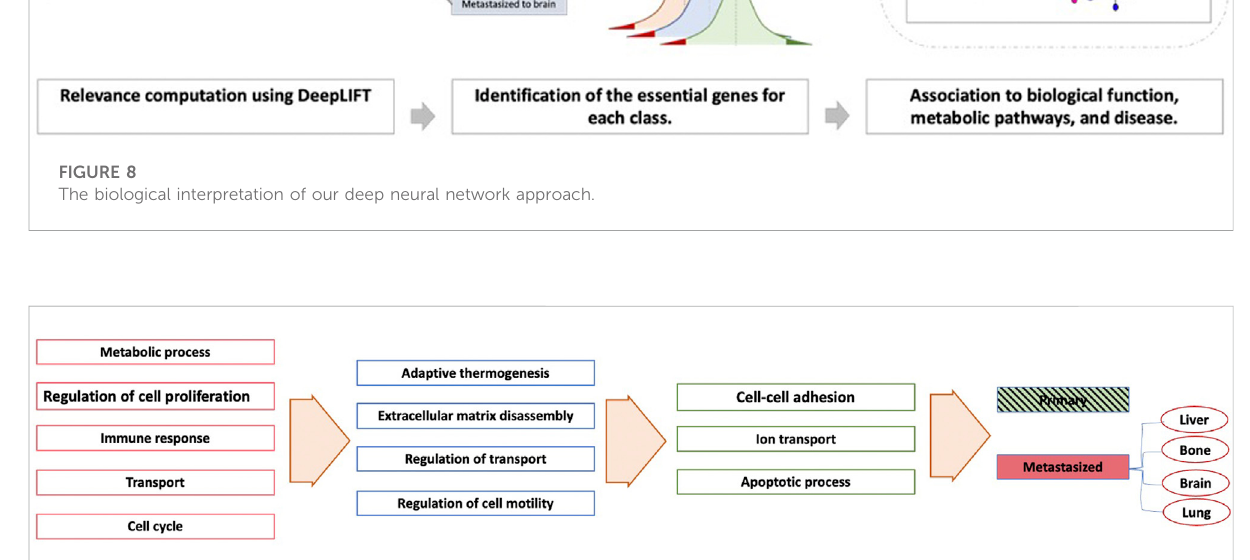
FIGURE 9 A simpli fi ed network showing each layer ’ s enriched pathways based only on the metastasis